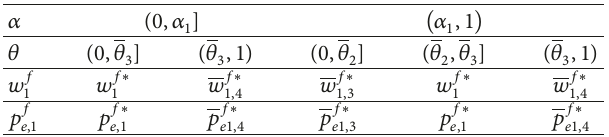
Table 2: The partial equilibrium strategies of the manufacturer in R1.